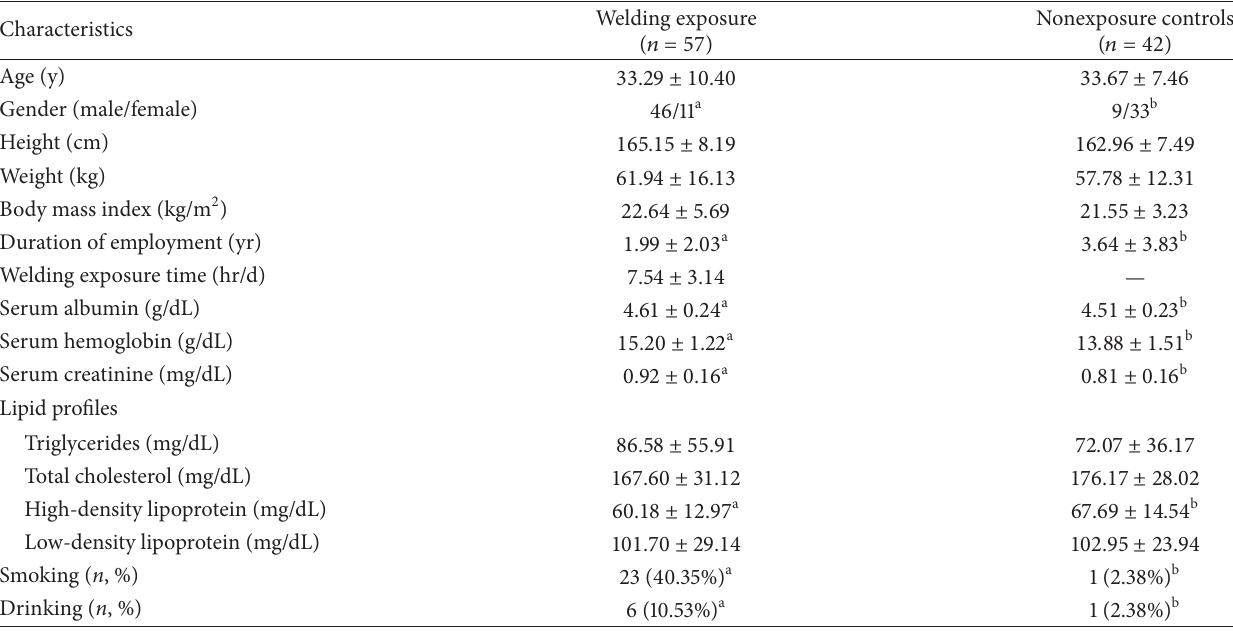
Table 1: Demographic and clinical characteristics of participants.